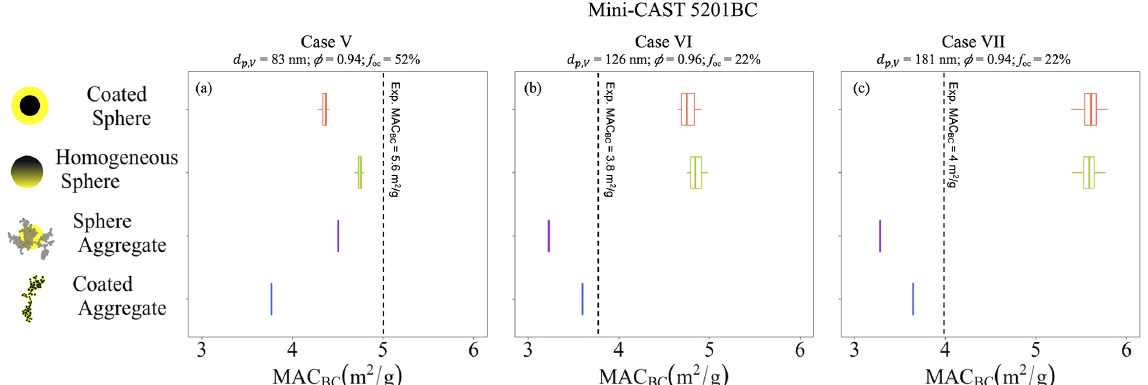
Figure 11. The asymmetry parameter g is modelled using the four representations of coated BC, i.e. “coated sphere”, “homogeneously mixed sphere”, “coated aggregate”, and “aggregate and sphere”. For each representation, the g is modelled using monodisperse particles (with d and d ). The results are shown for E2 cases V–VII: miniCAST 5201BC d p ,V = 181nm (c) . miniCAST 5201BC d p ,V